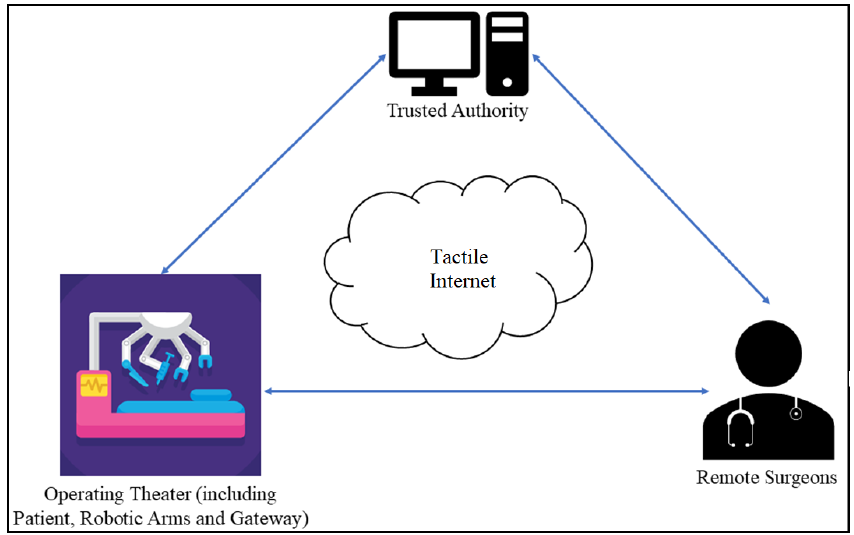
Figure 1. A simple model of a Tactile Internet remote surgery application.